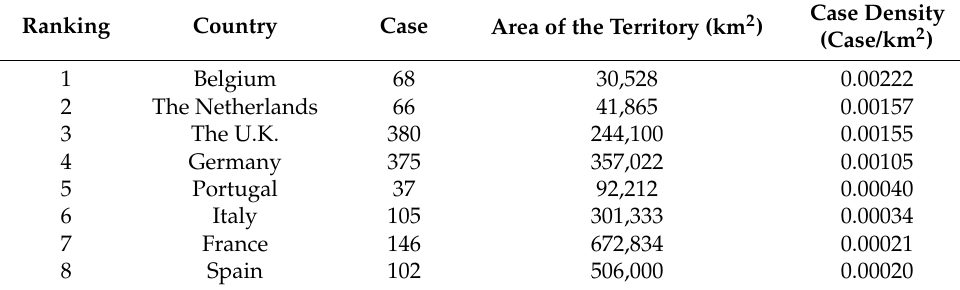
Table 5. Industrial tourism case density ranking of Belgium’s surrounding countries in ERIH. Ranking Country Case Area of the Territory (km 2 )